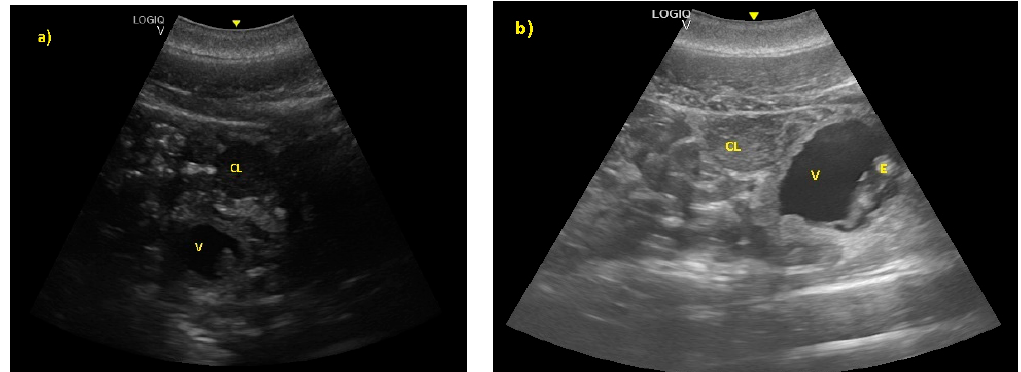
Figure 2. ( a ) The embryonic vesicle at 38 ± 2 days post-ovulation appeared as a roundish structure